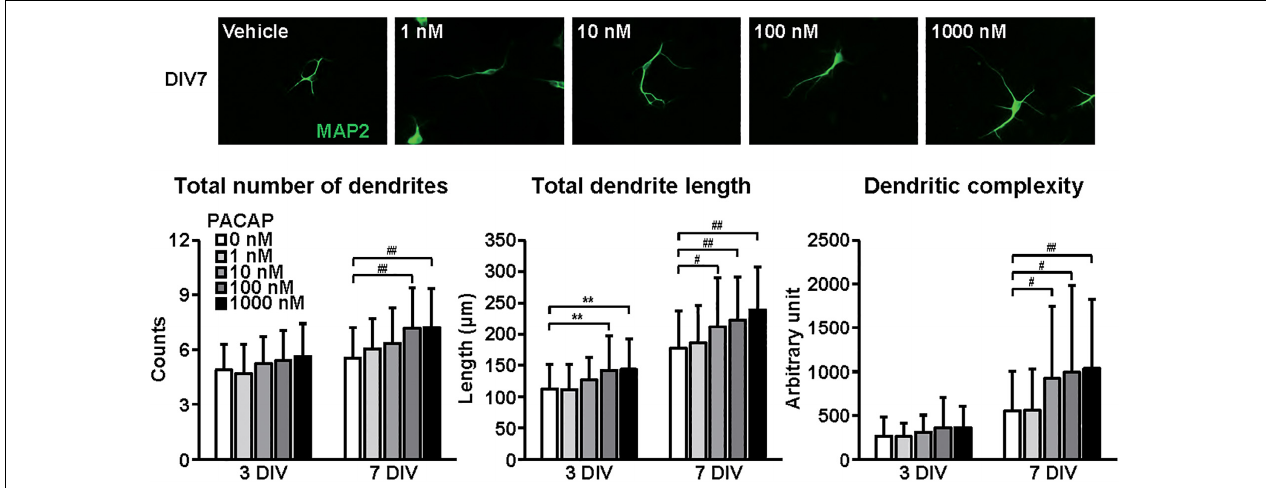
FIGURE 4 | Effects of PACAP on dendritic outgrowth in cultured cortical neurons. Representative MAP2 (green)-immunostained images of neurons cultured with PACAP (1–1000 nM) for 7 days in vitro (DIV) are shown. Quantitative analysis of dendritic morphology at 3 ( Figure 1B ) and 7 DIV revealed that PACAP dose-dependently increased the total numbers (main effects: F 1 , 510 = 63.825, P < 0.0001 for time, F 4 , 510 = 9.171, P < 0.0001 for treatment; interaction: F 4 , 510 = 1.661, P > 0.05) and length (main effects: F 1 , 510 = 231.606, P < 0.0001 for time, F 4 , 510 = 12.279, P < 0.0001 for treatment; interaction: F 4 , 510 = 0.957, P > 0.05) of dendrites, and dendritic complexity (main effects: F 1 , 510 = 93.016, P < 0.0001 for time, F 4 , 510 = 6.279, P < 0.0001 for treatment; interaction: F 4 , 510 = 2.822, P < 0.05). Values represent mean ± SD of 40–60 neurons from three independent experiments. ** P < 0.01, # P < 0.05, ## P < 0.01 vs.